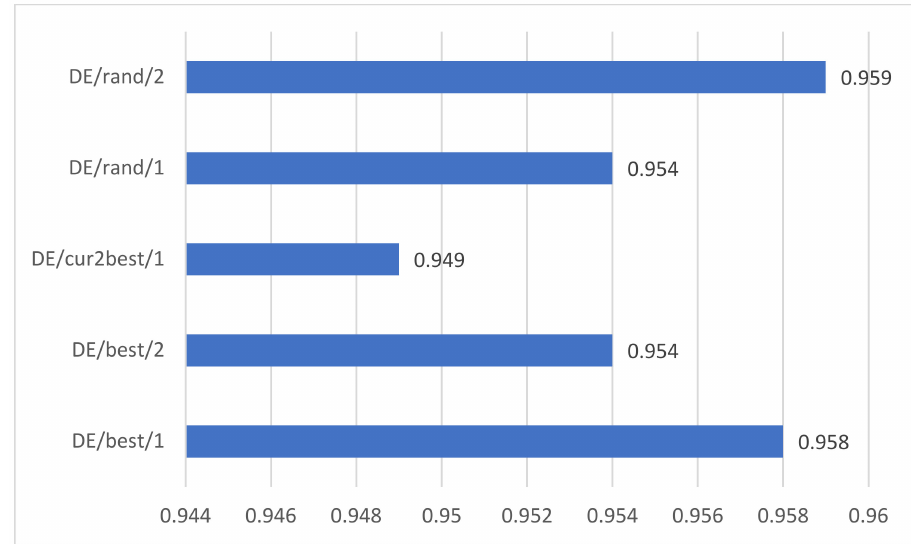
Figure 9. The prediction accuracy of the model using five different mutation